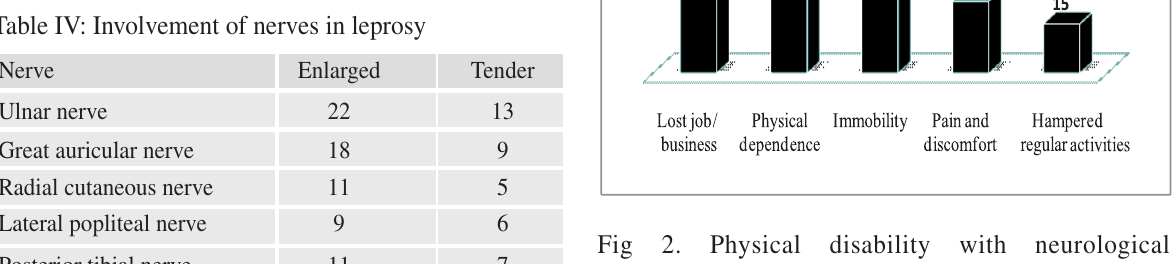
Fig 2. Physical disability with